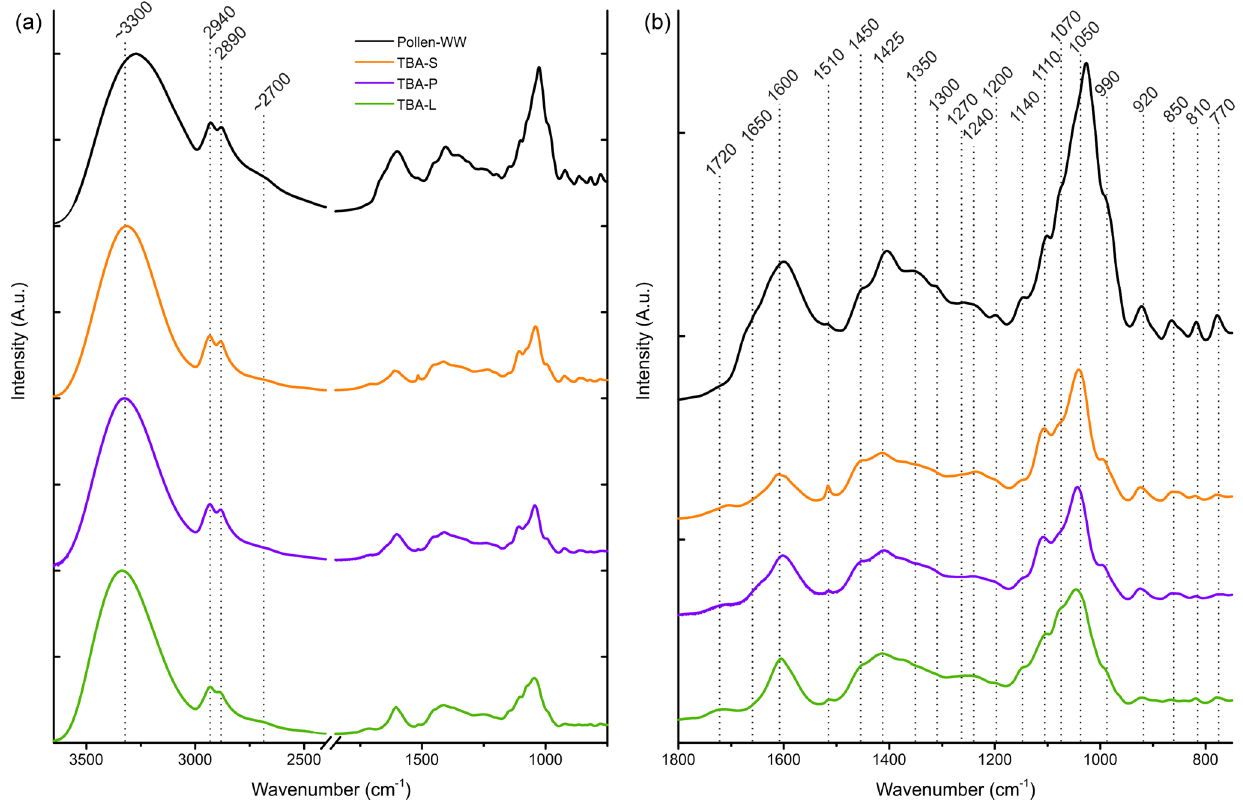
Figure 7. FTIR spectra of the TBA extracts (leaves in green, primary wood in violet, and secondary wood in orange) and birch pollen washing water (black). (a) The whole spectrum between 3650 and 750cm − 1 . (b) Enlarged right side of the spectrum between 1800 and 750cm − 1 . Possible band assignments are given in Table